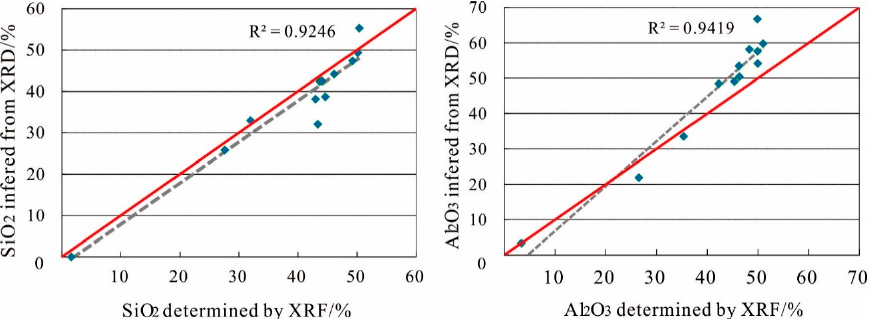
Figure 4. Comparison of observed normalized Si and Al oxide percentages from chemical analysis ( X -axis) to oxide percentages for sample ash inferred from XRD analysis data ( Y -axis). The diagonal line in each plot indicates equality.